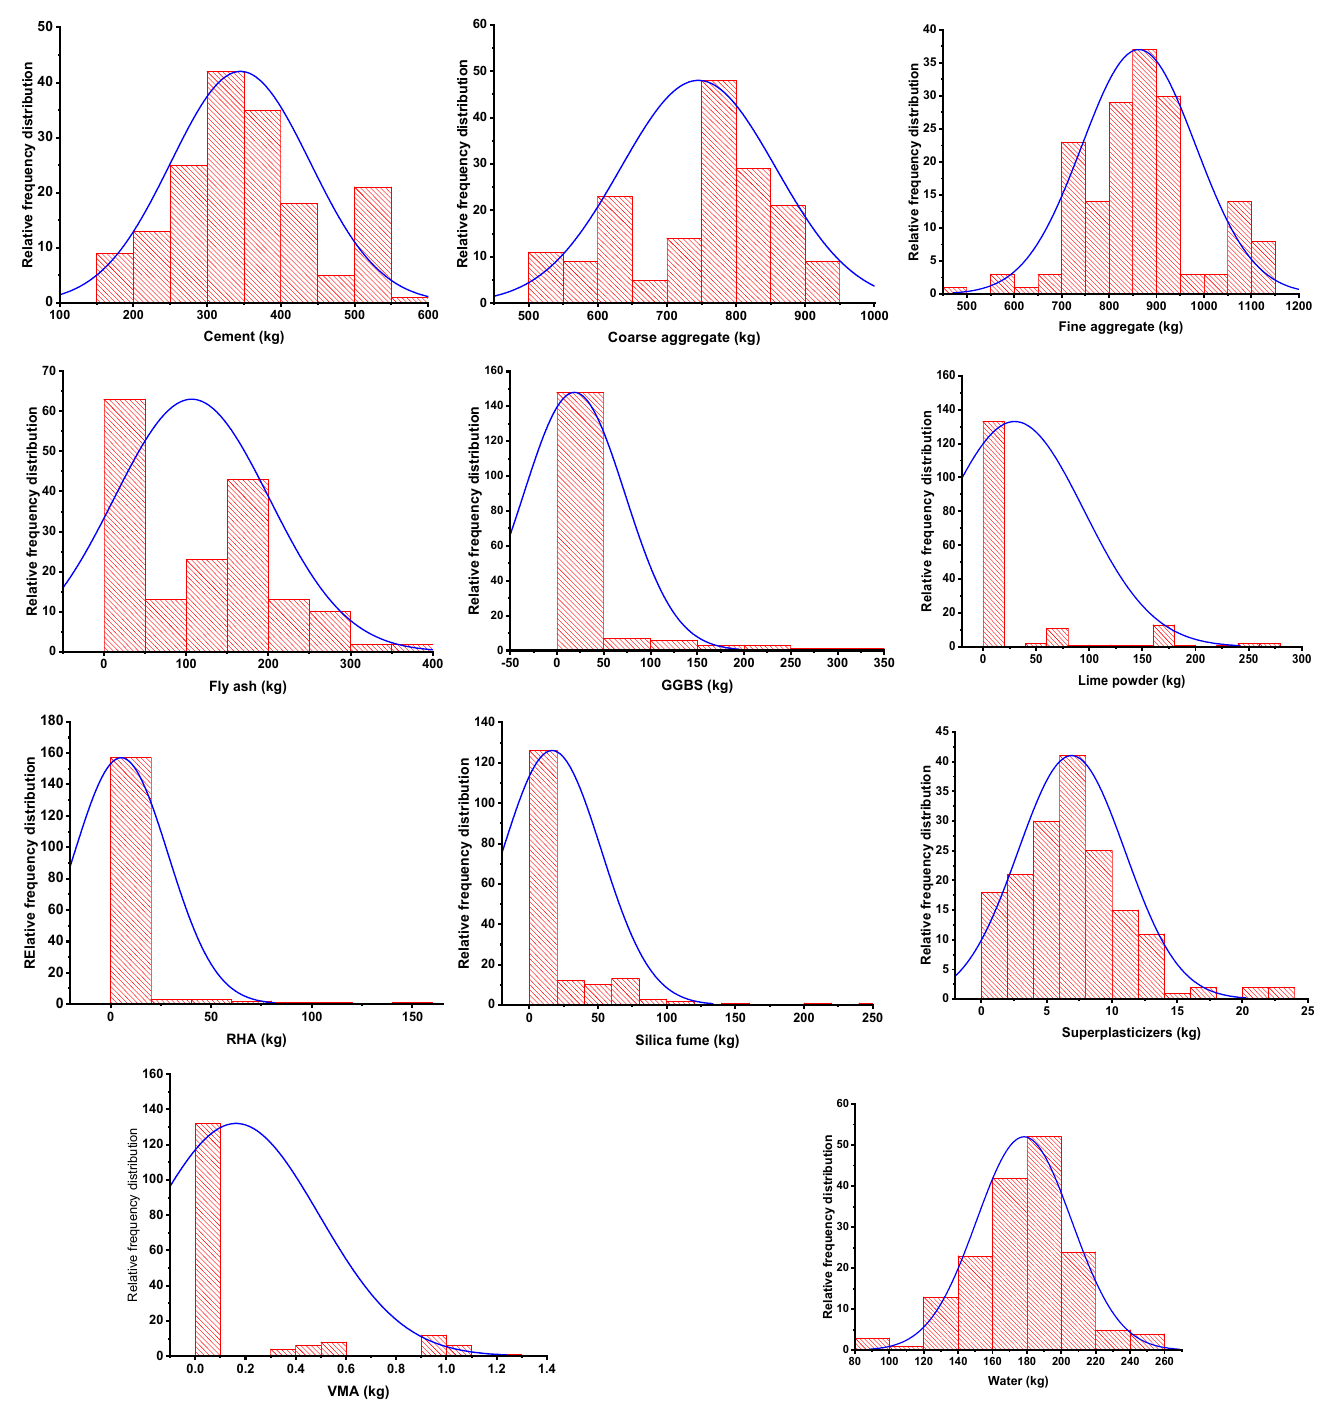
Figure 1. Input parameters’ relative frequency distribution.